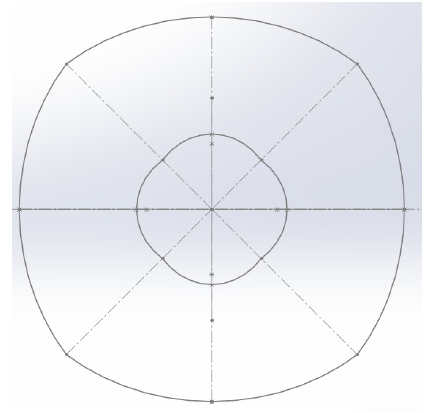
Figure 6. Representation of the two-fold symmetry of the cross section.